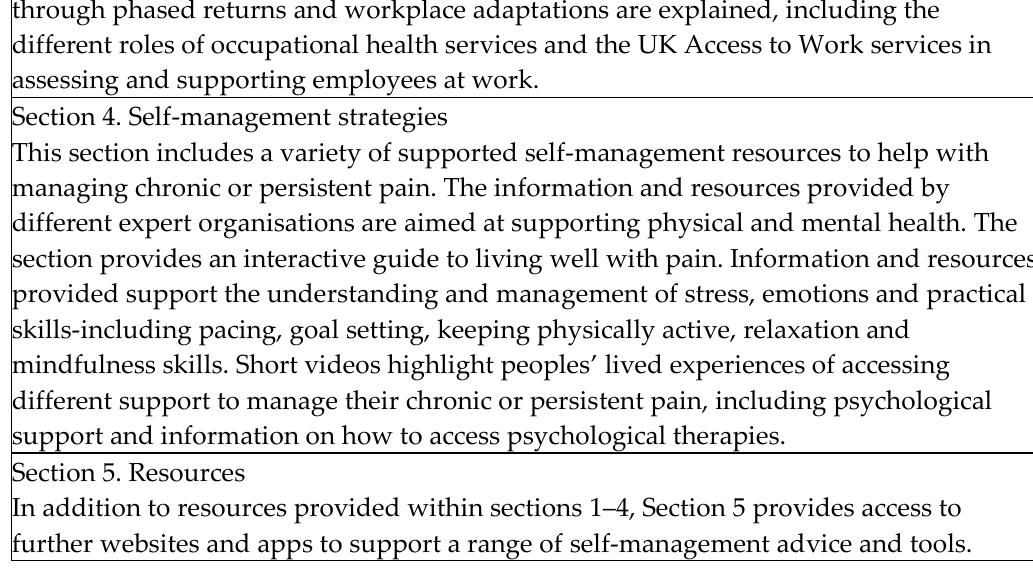
Figure 3. PAW Toolkit sections and